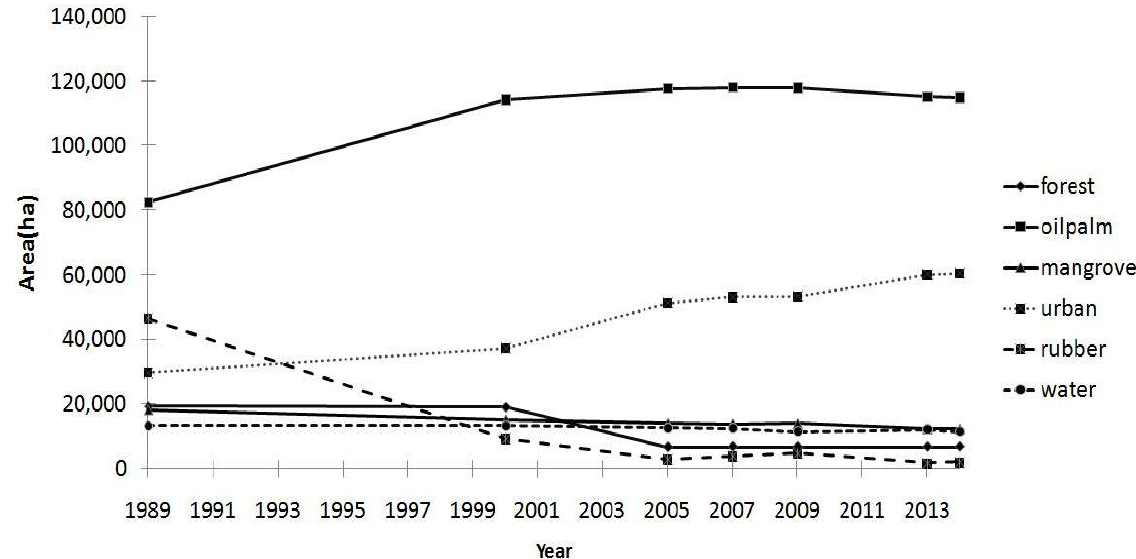
Figure 7. Trend in land cover changes in Iskandar Malaysia since